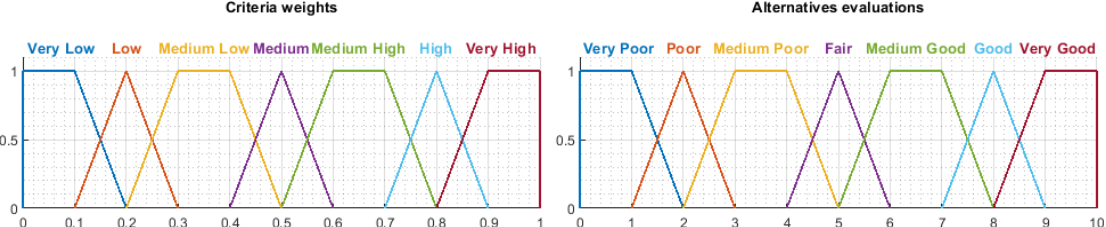
Figure 1. Linguistic scales used in the fuzzy TOPSIS method.